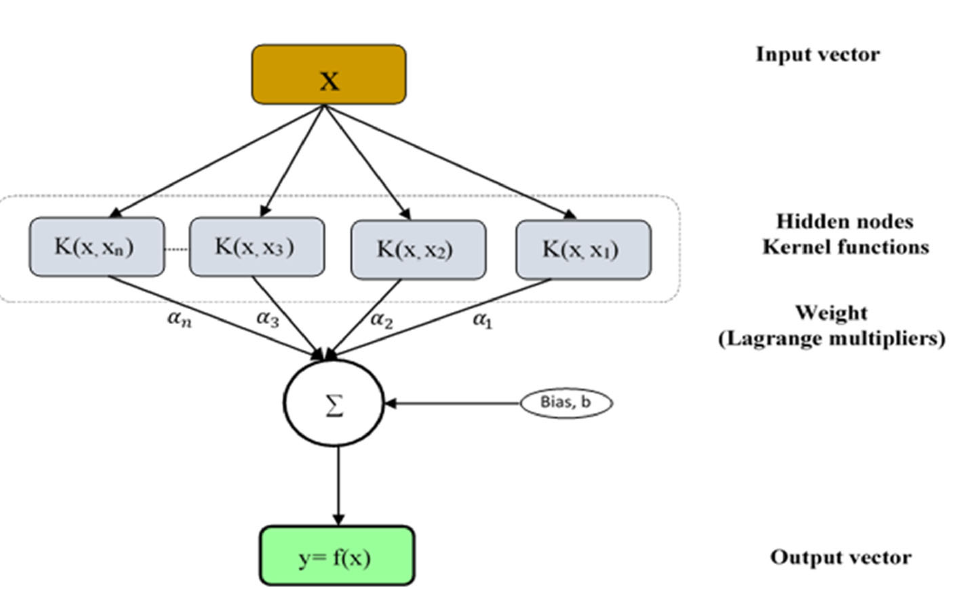
Figure 3. Conceptual structure of SVR model [31].